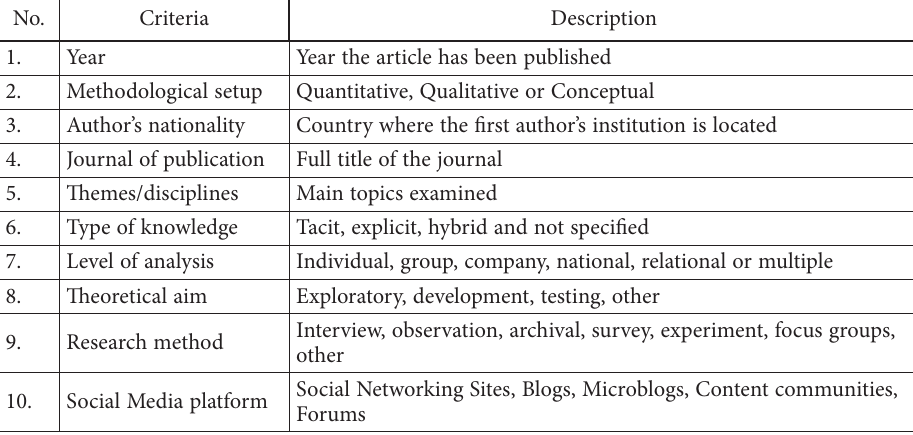
Table 1. Criteria utilized (source: adapted from McNulty, Zattoni, and Douglas,